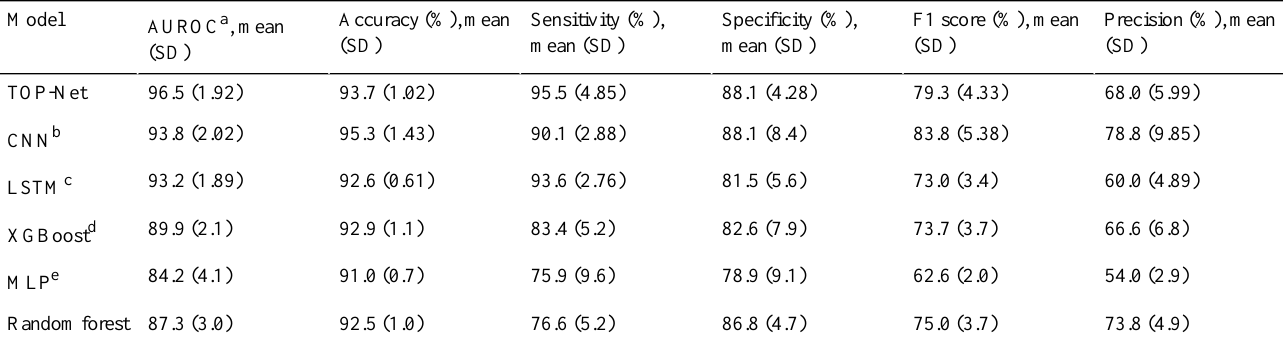
Table 5. TOP-Net performance based on transfer learning in the general ward (2-hour forecast